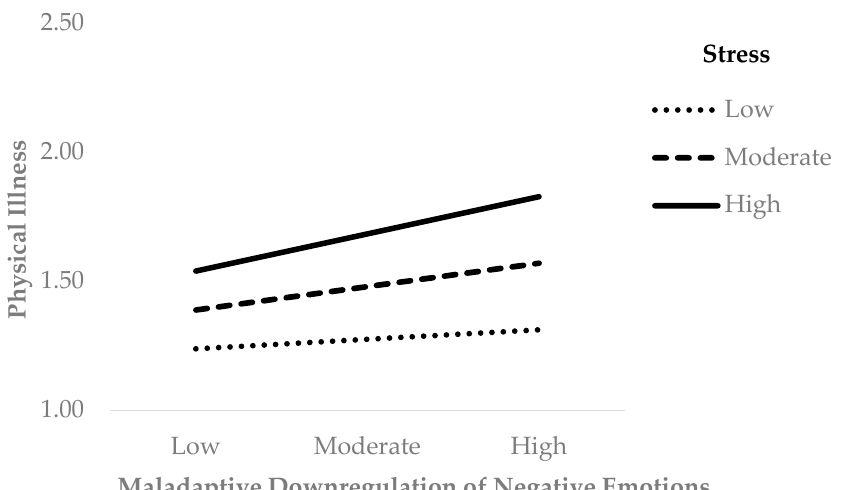
Figure 9. Maladaptive downregulation of positive emotions predicting burnout as a function of stress.